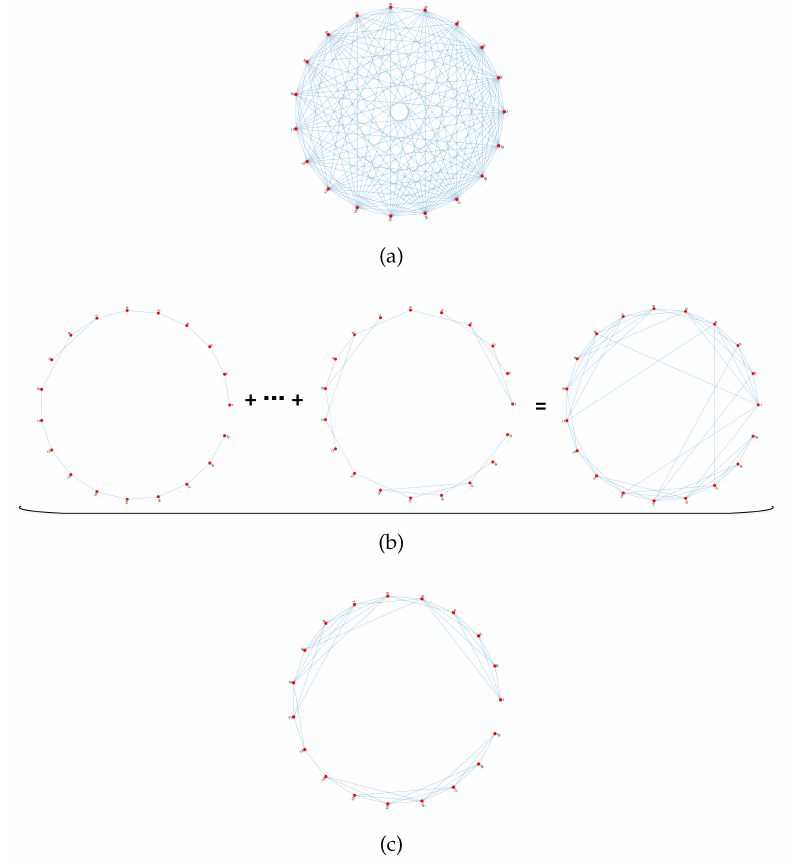
Figure 7. Illustrative process of generating the filtered seed view-graph: ( a ) original view-graph; ( b ) seed view-graphs obtained by uniting a number of MSTs; and ( c ) filtered seed view-graph after outlier elimination using